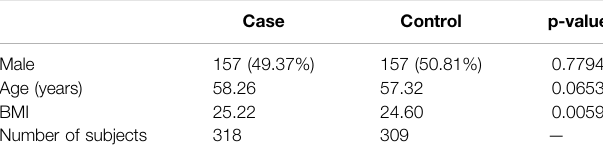
TABLE 2 | The characteristics of the subjects in each case (pre T2D + T2D) and control (Normal) group.